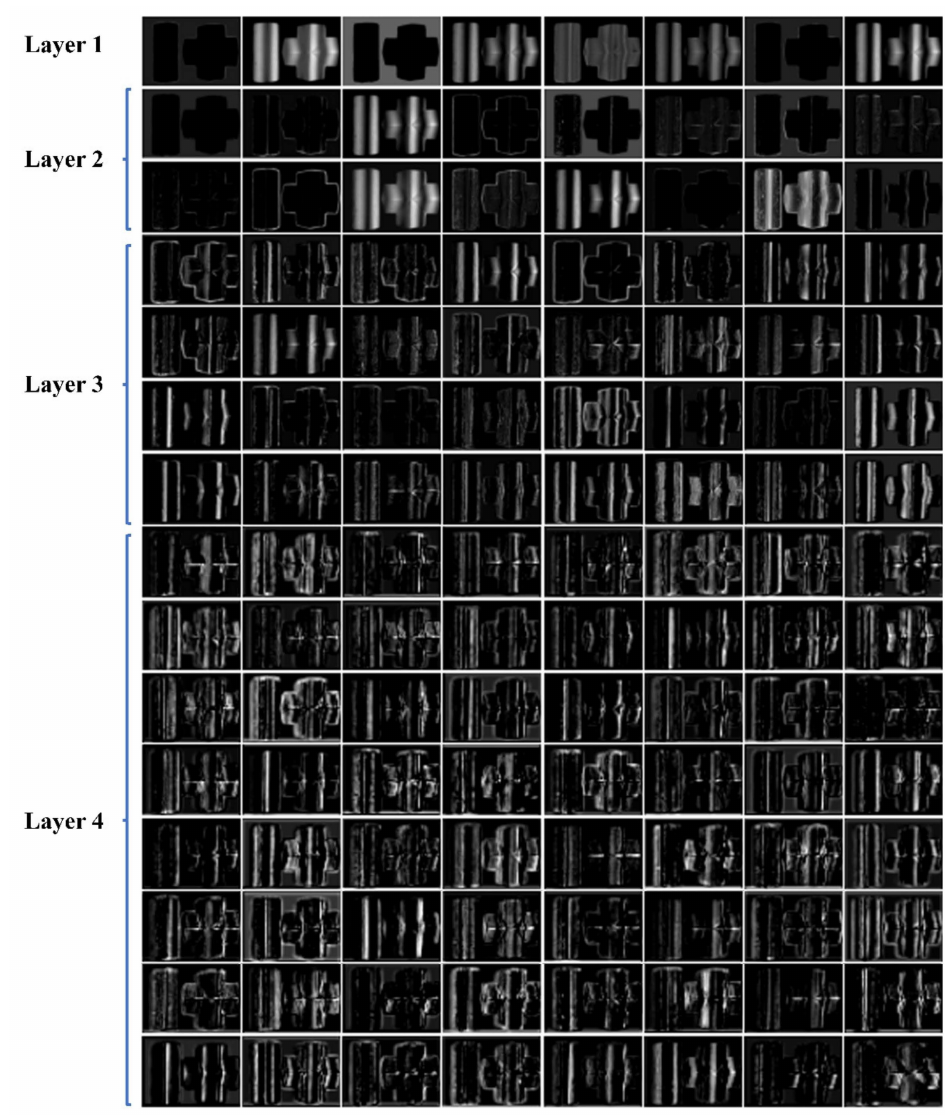
Figure 8. Feature maps of different coding layers based DLFT